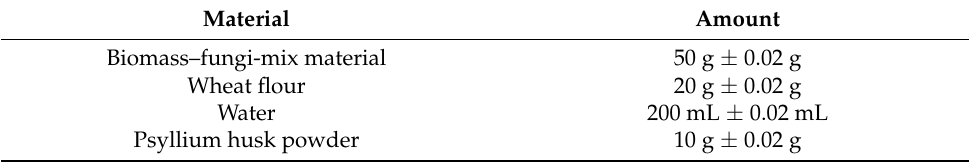
Table 1. Mixture composition for each batch of 50 g biomass–fungi-mix material. Material Amount Biomass–fungi-mix